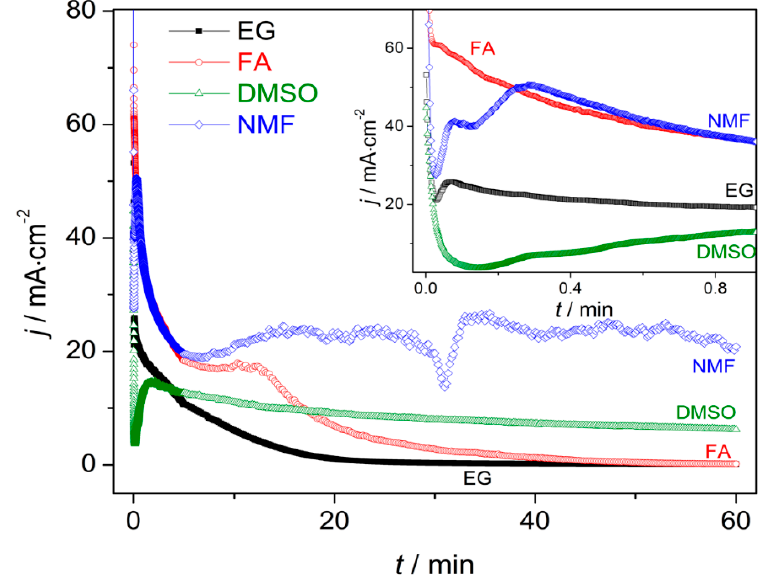
Figure 2. Current density anodization curves throughout the anodization [inset shows the transient period (1 min)] for ethylene glycol (EG), dimethyl sulfoxide (DMSO), formamide (FA) and N-methylformamide (NMF) samples.